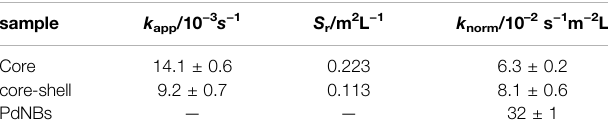
TABLE 1 | Apparent reaction rate constants k app were normalized towards the palladium mass per reaction volume S r to obtain k norm . The catalytic activity of apreviouslypreparedPNIPAM- co -MAccoreparticle(Sabadaschetal.,2022)was analyzed analogously to the core-shell system. In addition, data for the reduction of 4-nitrophenolate to 4-aminophenol with palladium nanoballs (PdNBs) were derived from literature (Kalekar et al., 2016). All data refer to experiments at 20 °